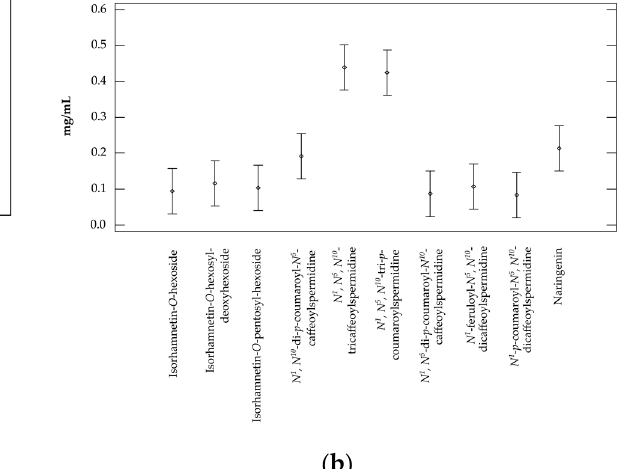
Figure 3. Graphical representation of the quantitative values of each compound: ( a ) representation of the range values of each compound by means of a boxplot; ( b ) mean and 95% intervals based on Fisher’s least significant difference (LSD) for each compound. The asterisk (*) indicates extreme outliers in the data.